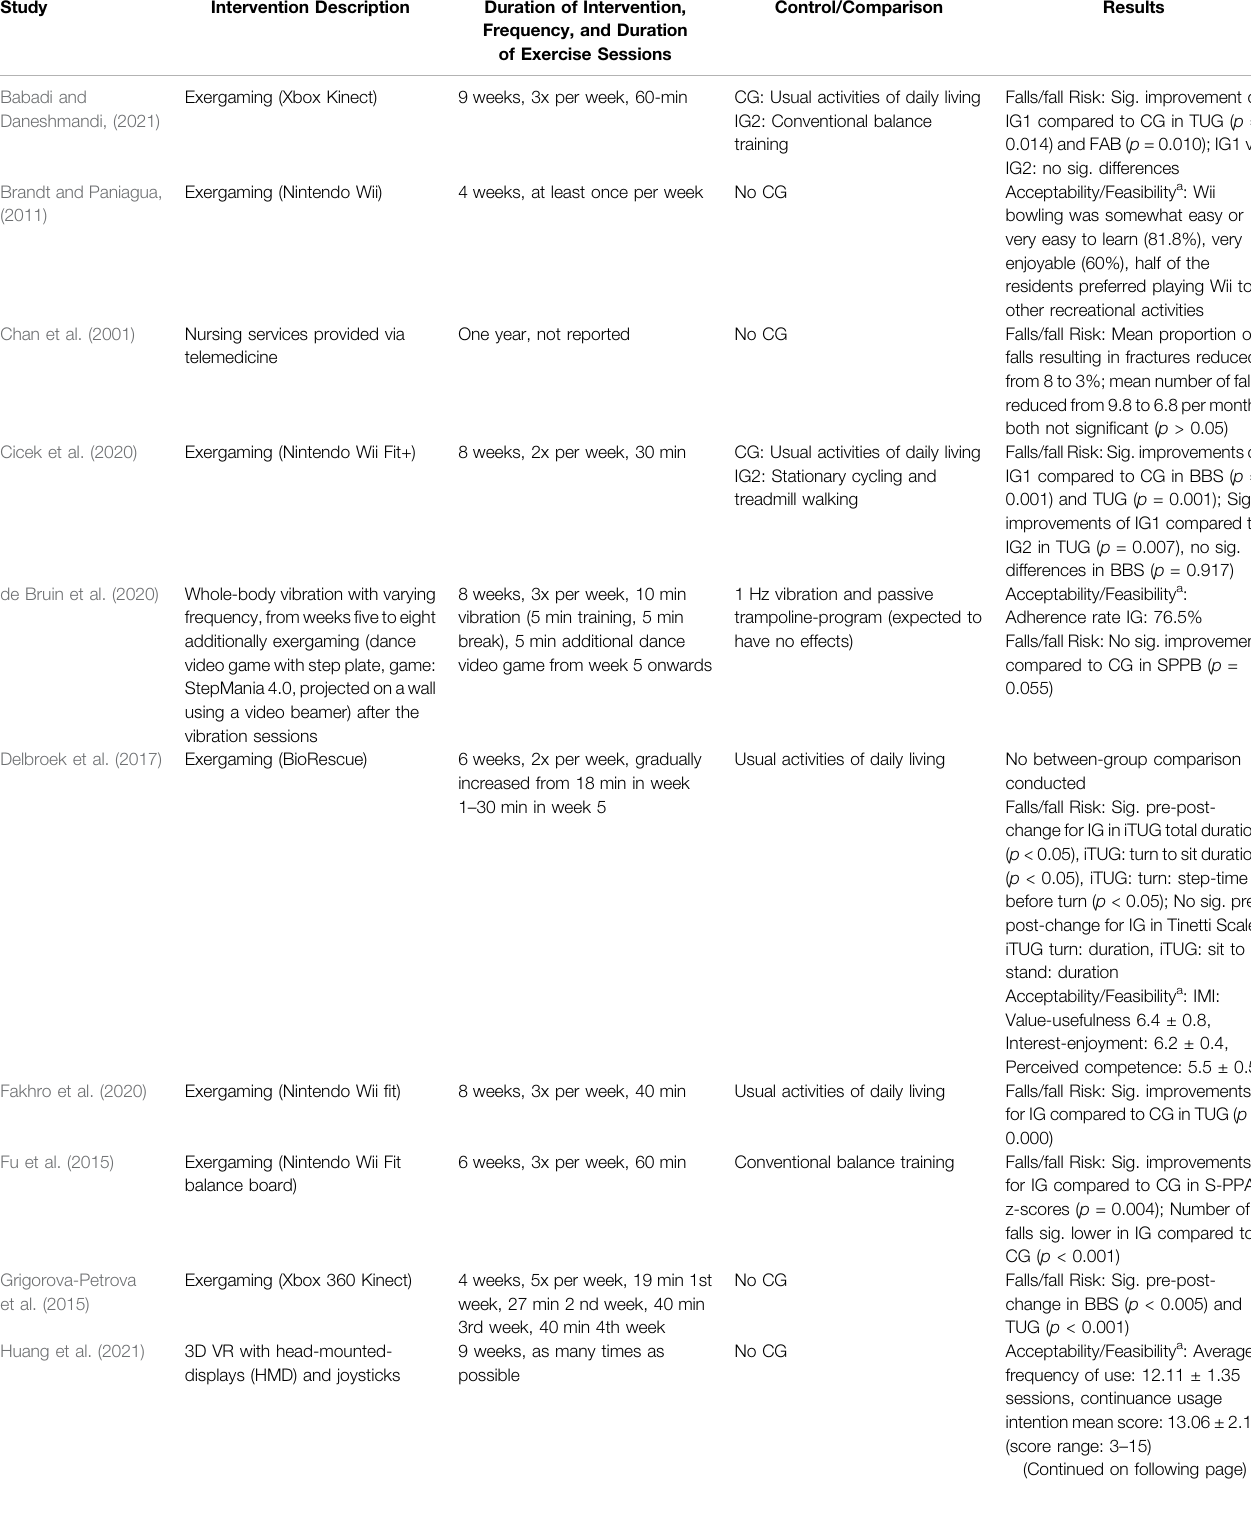
TABLE 3 | Intervention/control characteristics and results of primary